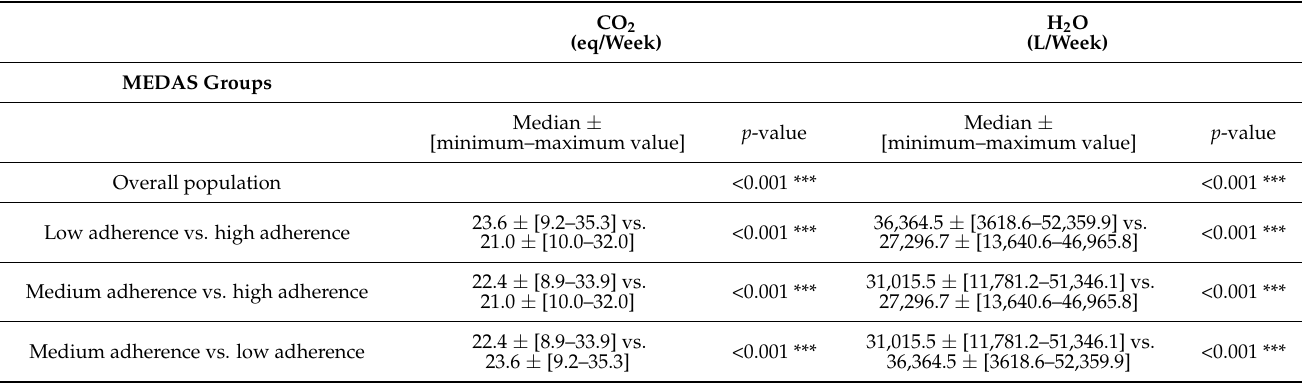
Table 5. Comparison between the occupation groups for CO 2 and H 2 O.